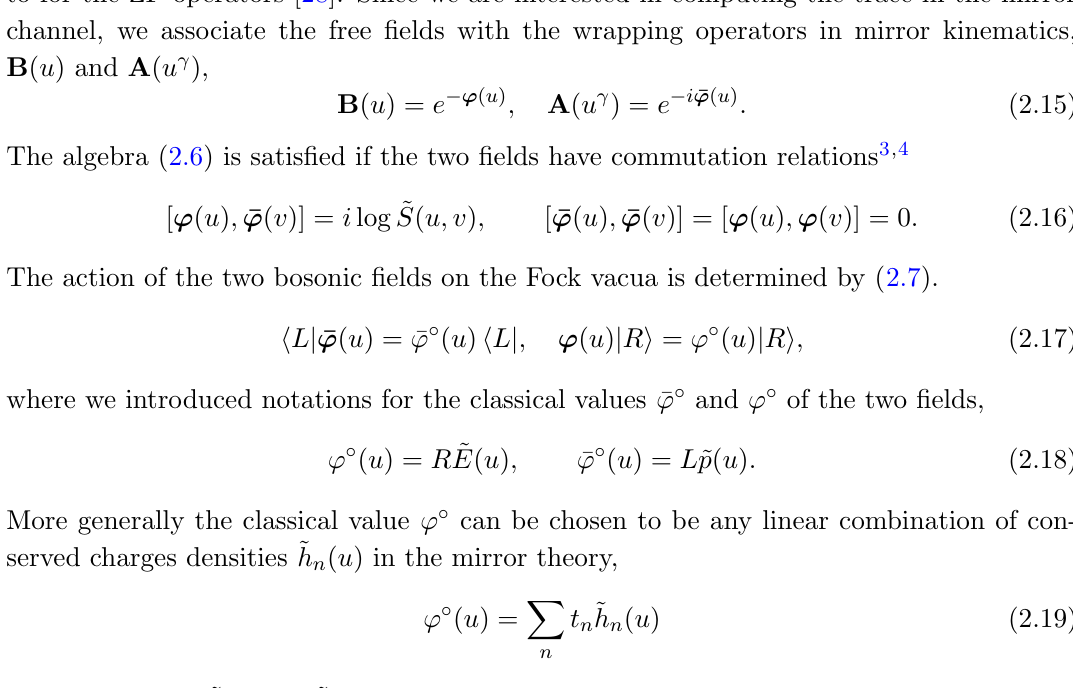
Figure 2 . Pictorial representation of the quantisation condition